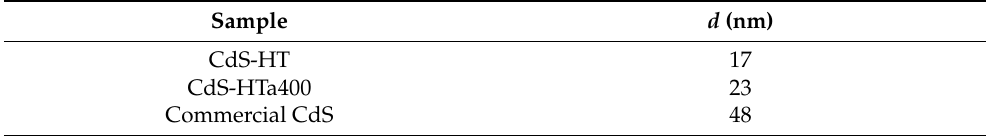
Table 1. Estimated average crystallite size by Debye Scherrer formula.